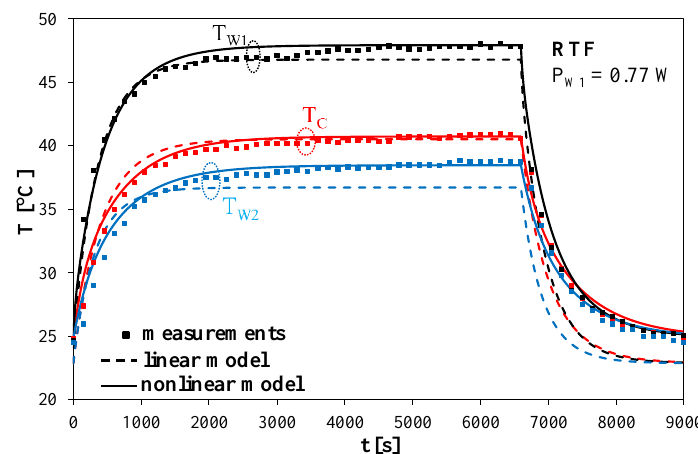
Figure 9. Measured and calculated waveforms of the temperature of the primary winding T W1 , the temperature of the secondary winding T W2 and the temperature of the core T C at a dissipated power P W1 of 0.77 W in the primary winding.